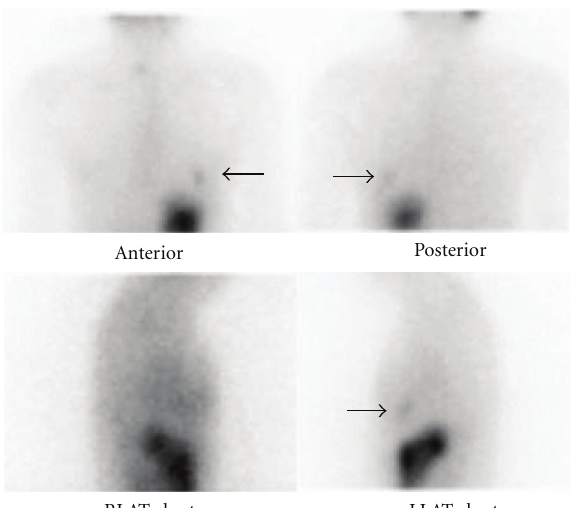
Figure 1: Whole-body scan immediately following 100 mCi (3700 MBq) thyroid remnant ablation showing uptake in thyroid bed and left hemithorax.